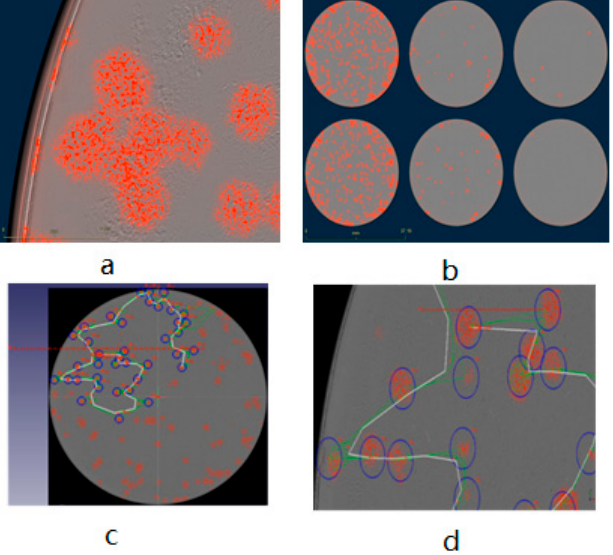
Figure 6. Fluorescence-dependent plaque assay. TurboFP635-labeled rVACV plaque assay based on wild-type CV-1 cells ( a , b ). ( a ) IE from ( b ) A1 well, scale bar = 2.3 mm. ( b ) Recombinant vaccinia virus L1c-Ig-Turbo-infected wild-type CV-1 cells, scale bar = 37.1 mm. Fluorescence-labeled viral plaques counted through FreeCAD software ( c , d ). ( c ) Viral plaque counting with L1c-Ig-Turbo-in- fected wild-type CV-1 cells through the FreeCAD software. ( d ) IE from ( c ) .